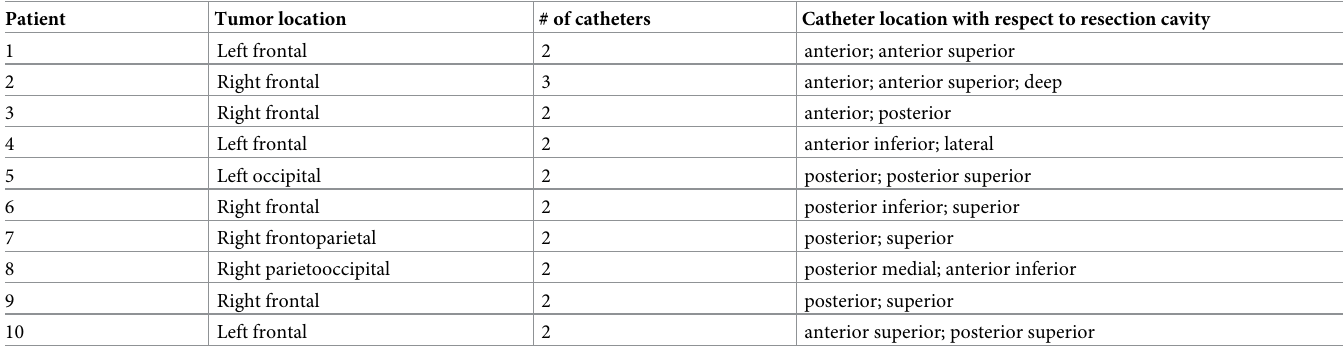
Table 2. Tumor location and catheter placement.